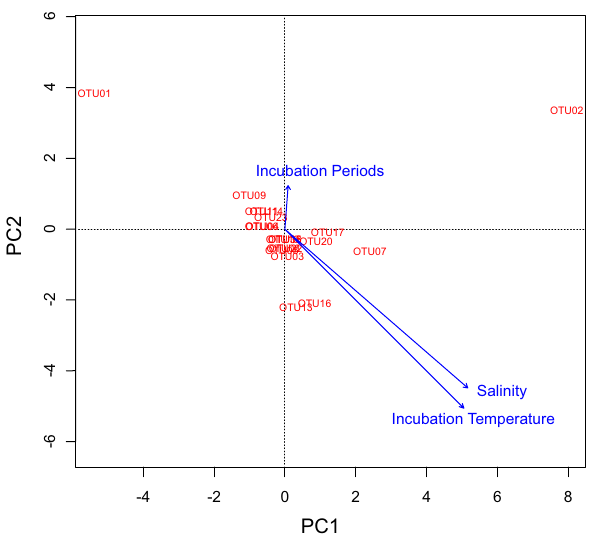
Figure 6. Redundancy analysis (RDA) based on the relative abundances of the most influential 20 OTUs (obtained through similarity percentage, SIMPER analysis) and environmental features. The arrows indicating the influences of the environmental parameters/conditions and the length of the arrows signified the magnitude of the influences. The most influential OTUs were mostly from the phylum Proteobacteria such as—OTU01 = SAR11_clade, OTU02 = Alteromonas , OTU07 = Alteromonas , OTU16 = Photobacterium , OTU13 = Aurantivirga , OTU05 = Prochlorococcus , OTU08 = SAR11_clade, OTU09 = SAR86_clade, OTU06 = SAR86_clade, OTU20 = Alcanivorax , OTU17 = Alteromonas , OTU11 = SUP05_cluster, OTU04 = SAR11_clade, OTU14 = NS5_marine_group, OTU19 = SAR11_clade, OTU18 = SAR11_clade, OTU22 = Rhodobacteraceae , OTU03 = Vibrio, OTU23 = SAR11_clade, and OTU35 = Bacteria_unclassified. In the sample names K = Kuroshio, PS = SPG surface, PX = SPG Chlorophyll maximum, TS = STG